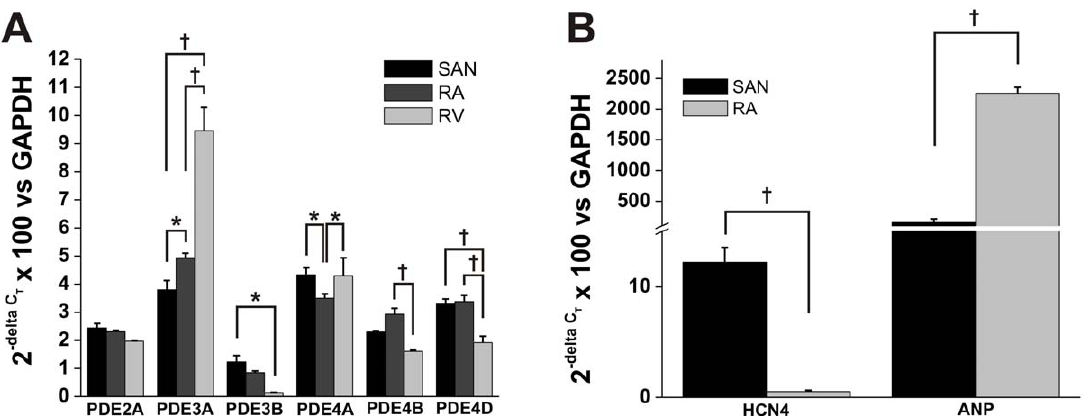
Figure 1. Quantitative mRNA expression of PDE 2, 3 and 4 subtypes in mouse SAN, right atrium and right ventricle. A. Expression of PDE2A, PDE3A, PDE3B, PDE4A, PDE4B and PDE4D are shown relative to GAPDH for the SAN, right atrium (RA) and right ventricular free wall (RV). B. SAN samples were distinguished from RA samples by the characteristic pattern of expression of HCN4 and ANP in these regions. SAN tissue shows high expression of HCN4 and low expression of ANP whereas the RA shows very low HCN4 expression and very high ANP expression. Note scale break on Y-axis. Data are means 6 SEM; n =5 SAN trials, 5 right atrial appendage trials and 3 right ventricular free wall trials; * P , 0.05; { P , 0.001 by two way ANOVA with Tukey’s posthoc test.